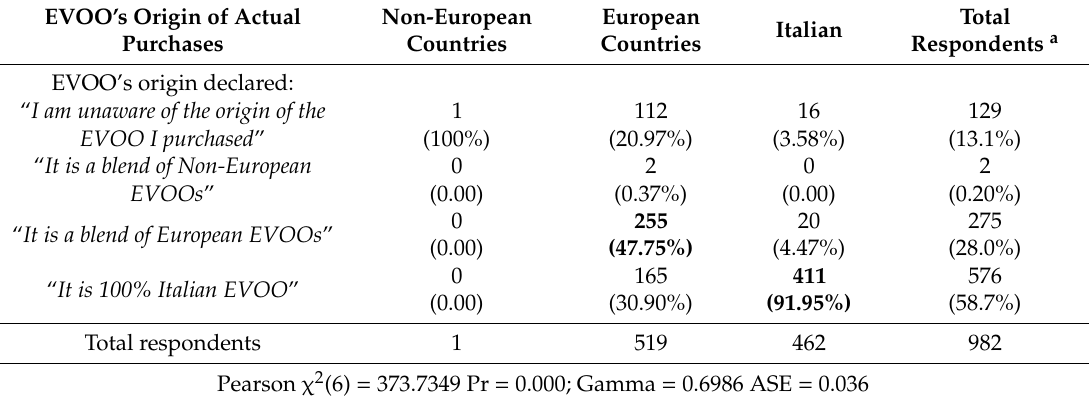
Table 3. Consumer-declared origin of the EVOO products purchased and the actual